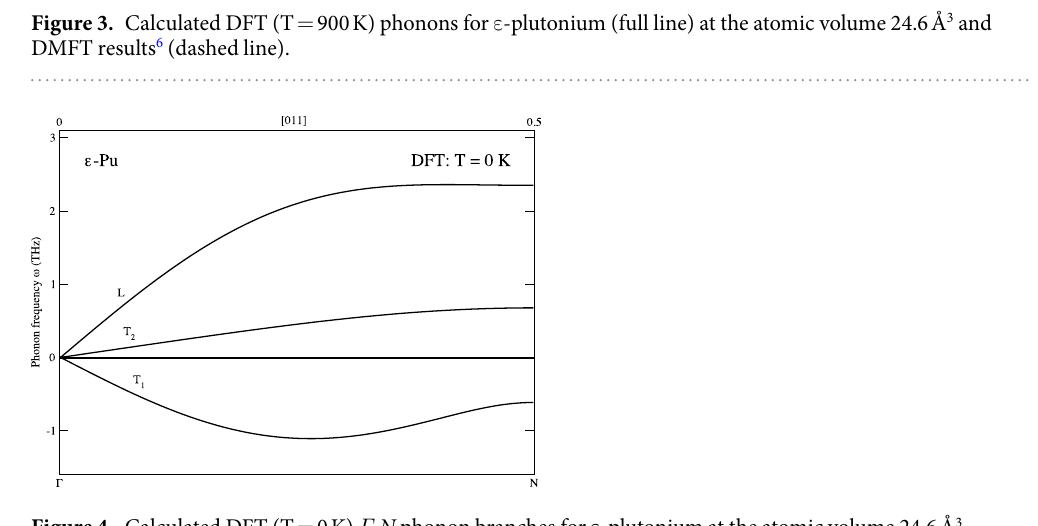
Figure 4. Calculated DFT (T = 0 K) Γ -N phonon branches for ε -plutonium at the atomic volume 24.6 Å 3 .